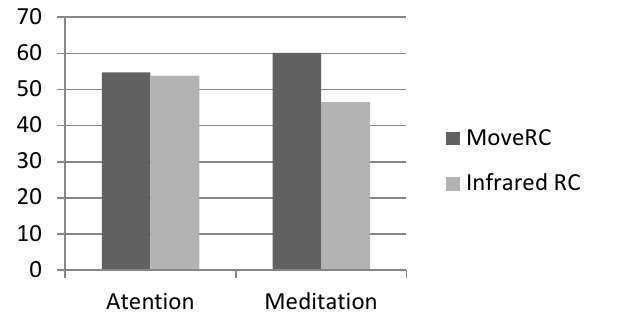
Fig. 10 – Average attention and meditation in the tasks The average for meditation with the MoveRC was 60.2%, vis-à-vis 46.5% of the IR RC, an increase of 29.4% in average user relaxation. The fact that the MoveRC solution promotes higher performance in the tasks, increasing user relaxation and maintaining the same levels of user attention as a common RC may be regarded as evidence that the MoveRC better allocates the user’s attention in the